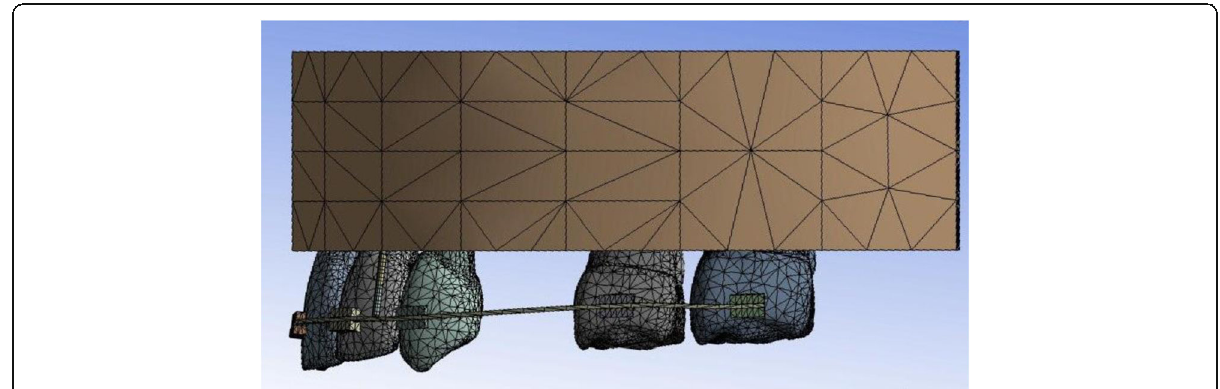
Fig. 1 Geometric models of the maxillary dental